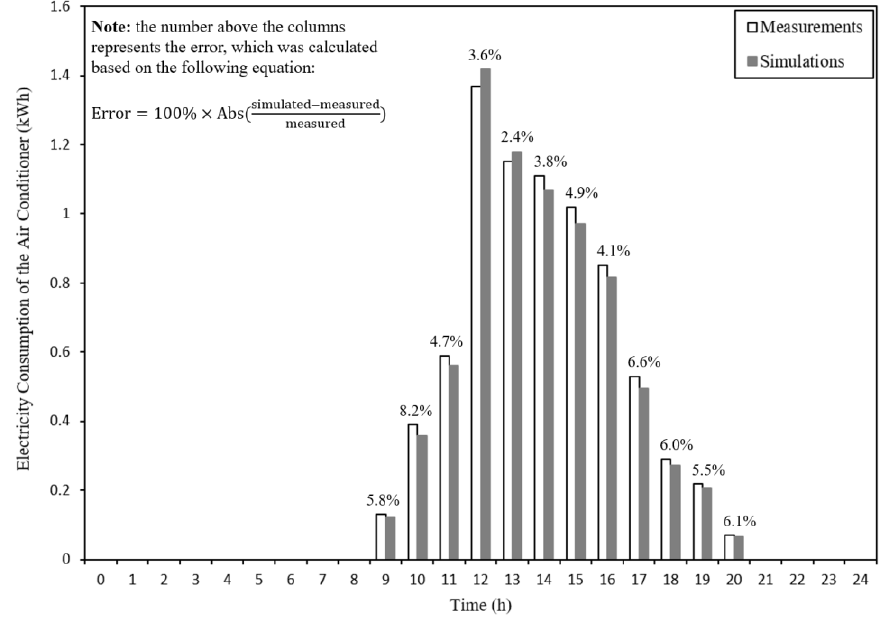
Figure 3. The measured and simulated electricity consumption of the air conditioner.